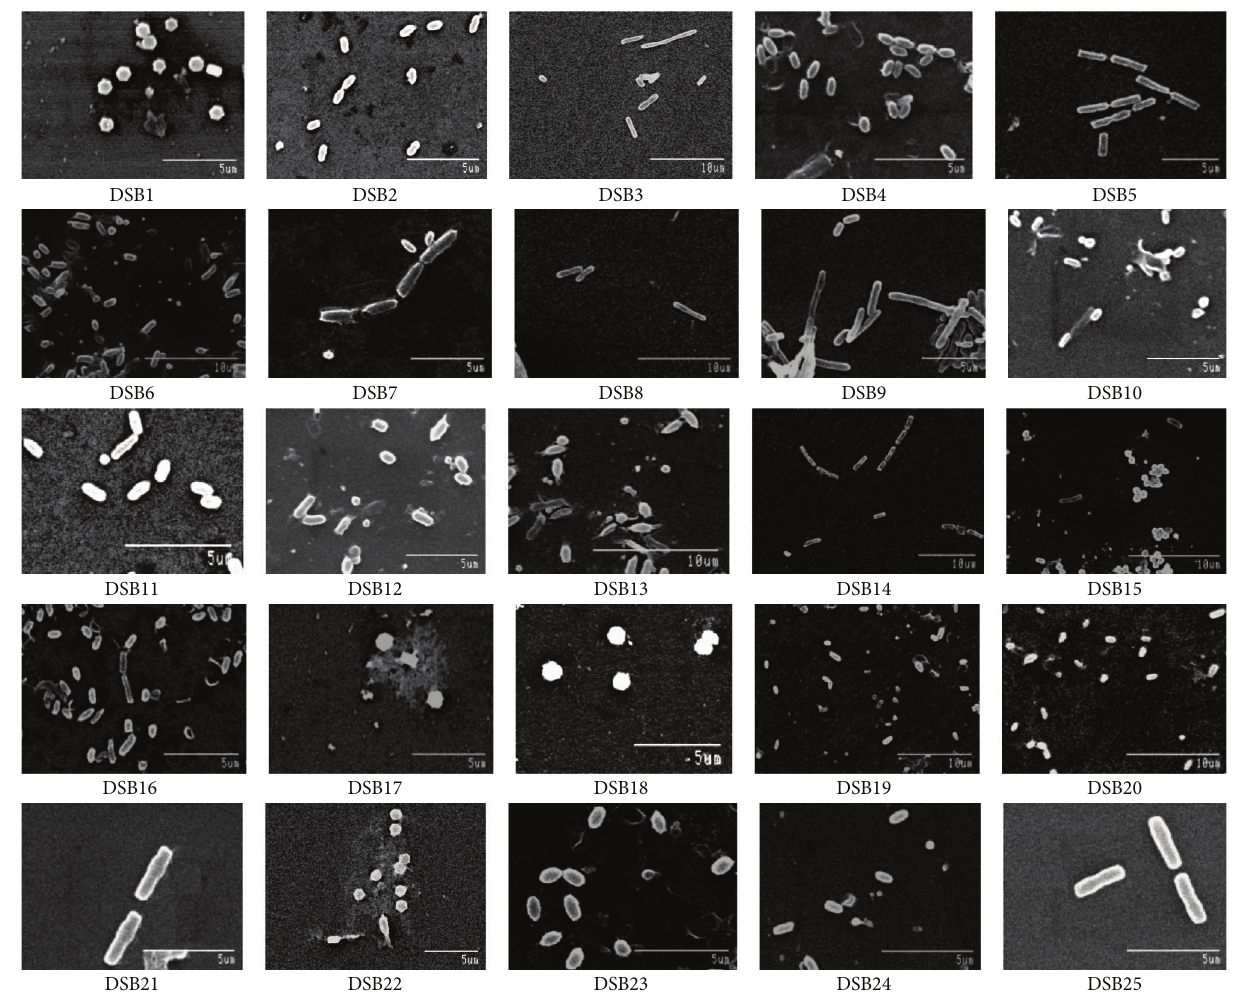
Figure 4: Scanning electron micrographs of the Bacillus spp. showing vegetative body, spores, and crystals (if